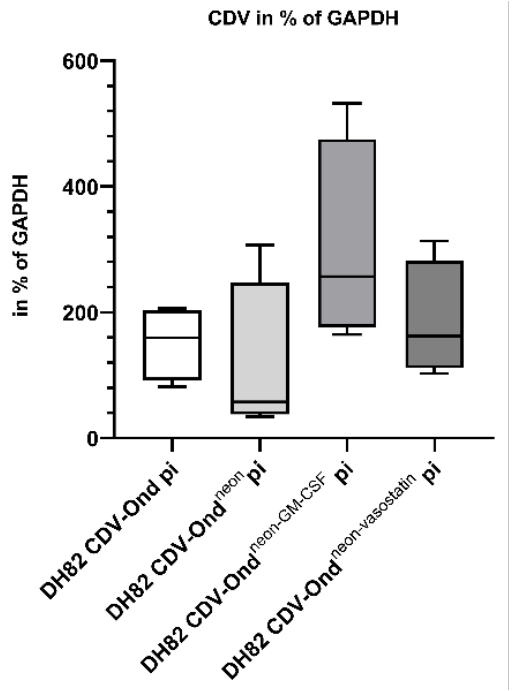
CDV mRNA transcripts.